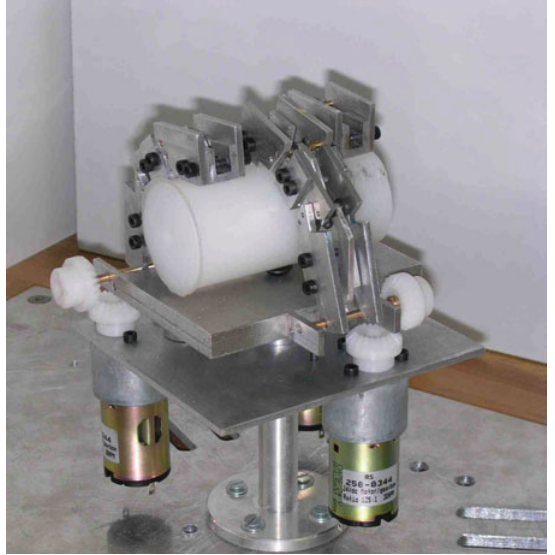
Figure 2 A prototype of three-fingered LARM hand with 1 d.o.f. anthropomorphic fingers of human